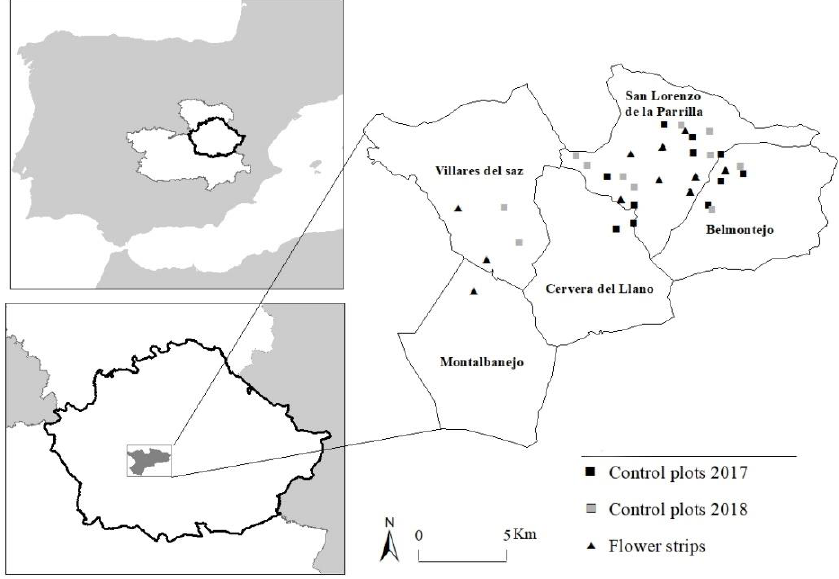
Figure 1. Location of the sampling plots in the study area in Cuenca, Spain.